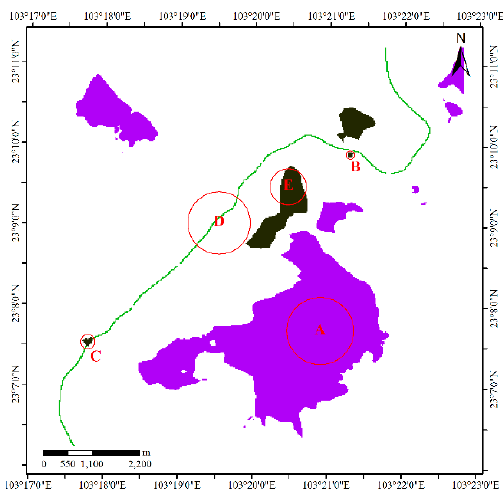
Figure 3. Simulated sika deer dataset. Figure 4. Obstacles to sika deer activities.